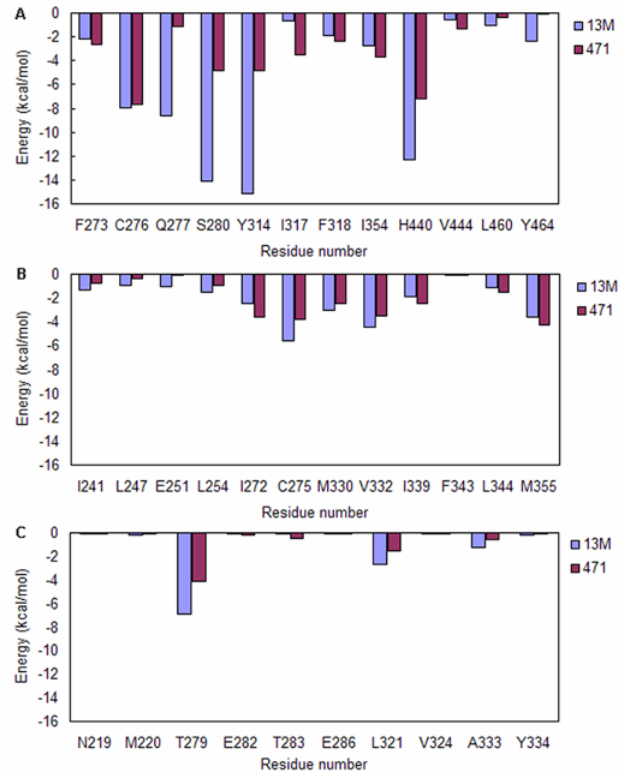
Figure 6. The average total interaction energies of agonist and antagonist with residues in ( A ) Arm I region; ( B ) Arm II region; and ( C ) Entrance